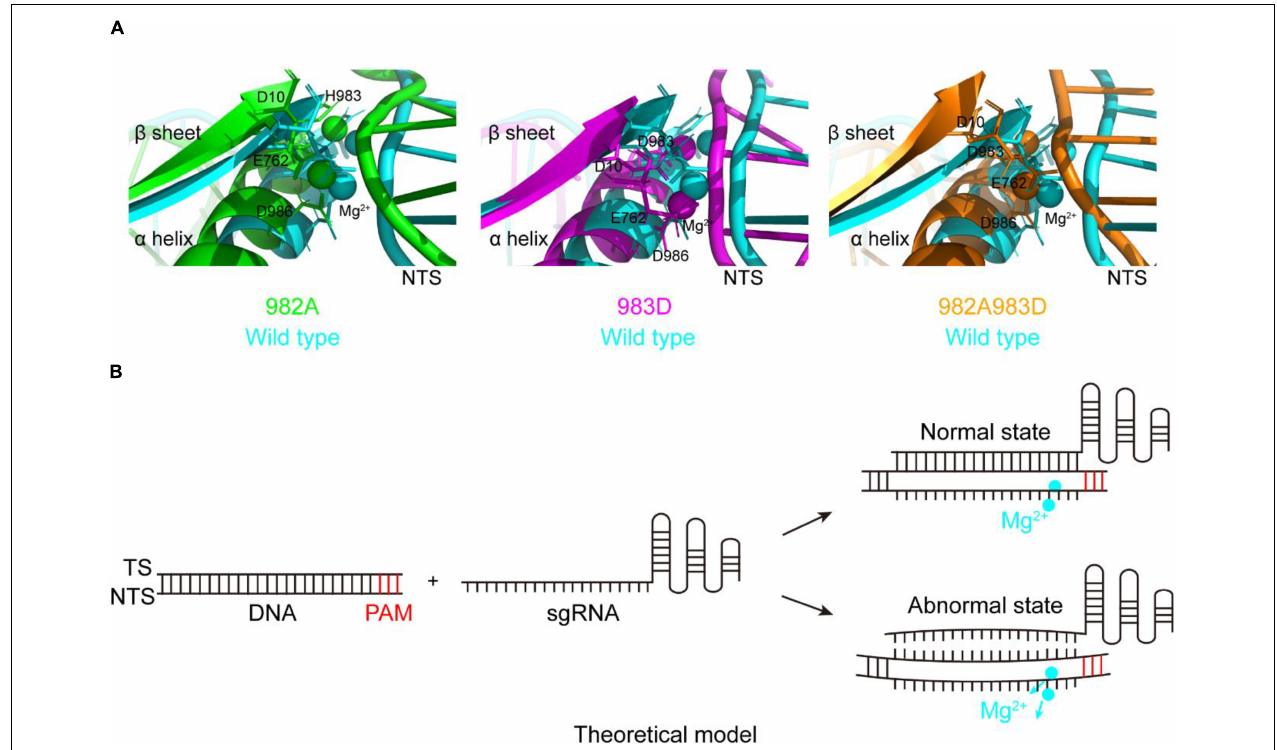
FIGURE 4 | The movement of the non-target strands (NTS) in the PAM distal ends. (A) In the RuvC active centers of SpCas9 mutants, the NTSes of the PAM distal ends are shifted due to the comformational change of the RuvC catalytic centers (especially magnesium ions). (B) The model of reducing off-targets of SpCas9. In these mutants (H982A, H983D, and H982A + H983D), when sgRNAs are not mathed with the NTS of the substrate DNA (in abnormal state), the DNA may be not cleaved by SpCas9 mutants.